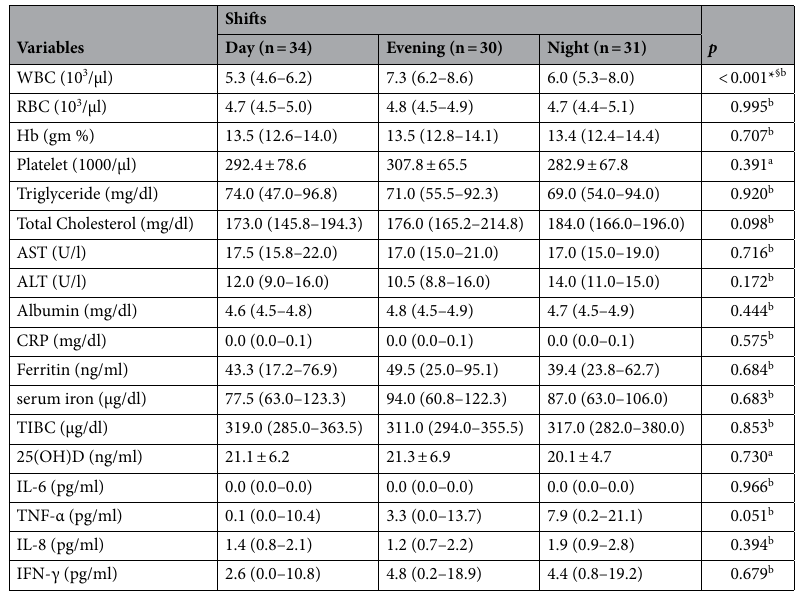
Table 2. Participant biochemistry of three class shift nurses. WBC, white blood cell count; RBC, red blood cells; Hb, hemoglobin; AST, aspartate aminotransferase; ALT, alanine aminotransferase; CRP, C-Reactive Protein; TIBC, total iron binding capacity; IL-6, interleukin-6; TNF-α, tumor necrosis factor-α; IL-8, interleukin-8; IFN-γ, interferon-γ. * p -value < 0.05( § Day shift v.s. evening shift; ₤ evening shift v.s. night shift; ￥ Day shift v.s. night shift). The power after calculation and analysis after the event: the number of subjects is